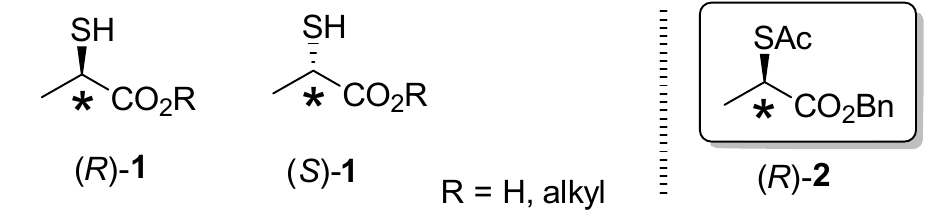
Figure 1. Chiral thiolactic acid and esters ( R )- 1 , ( S )- 1 , and benzyl (2 R )-2-(acetylthio)propanoate ( R )- 2 .